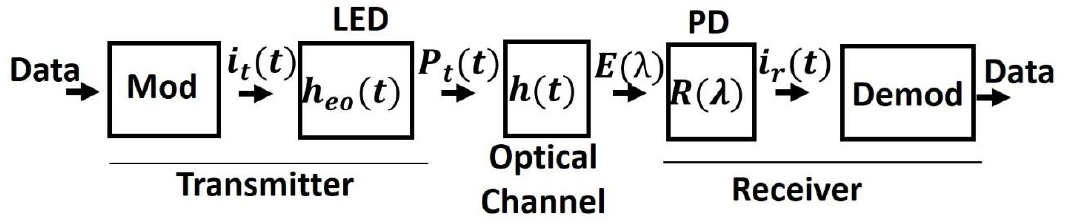
Figure 1. Block diagram of a visible light communication (VLC) system. LED — light-emitting-diode; PD — photodiode.